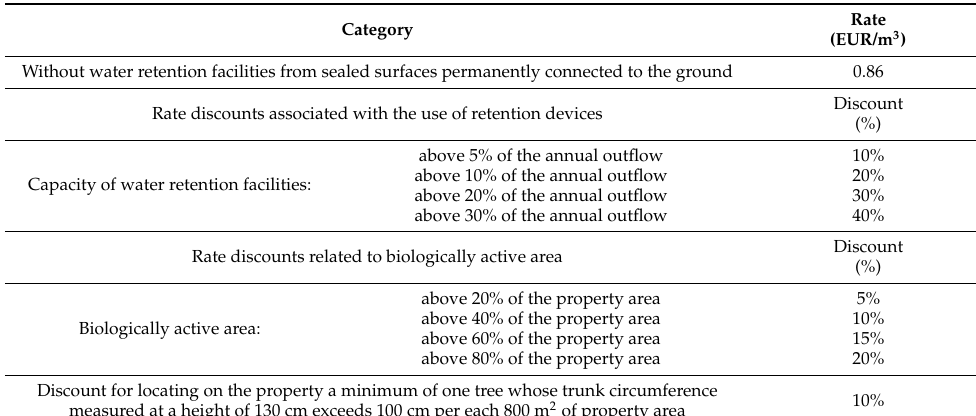
Table 4. Rates of fees for the discharge of rainwater into the sewer system in Konin [46]. Category Rate (EUR/m 3